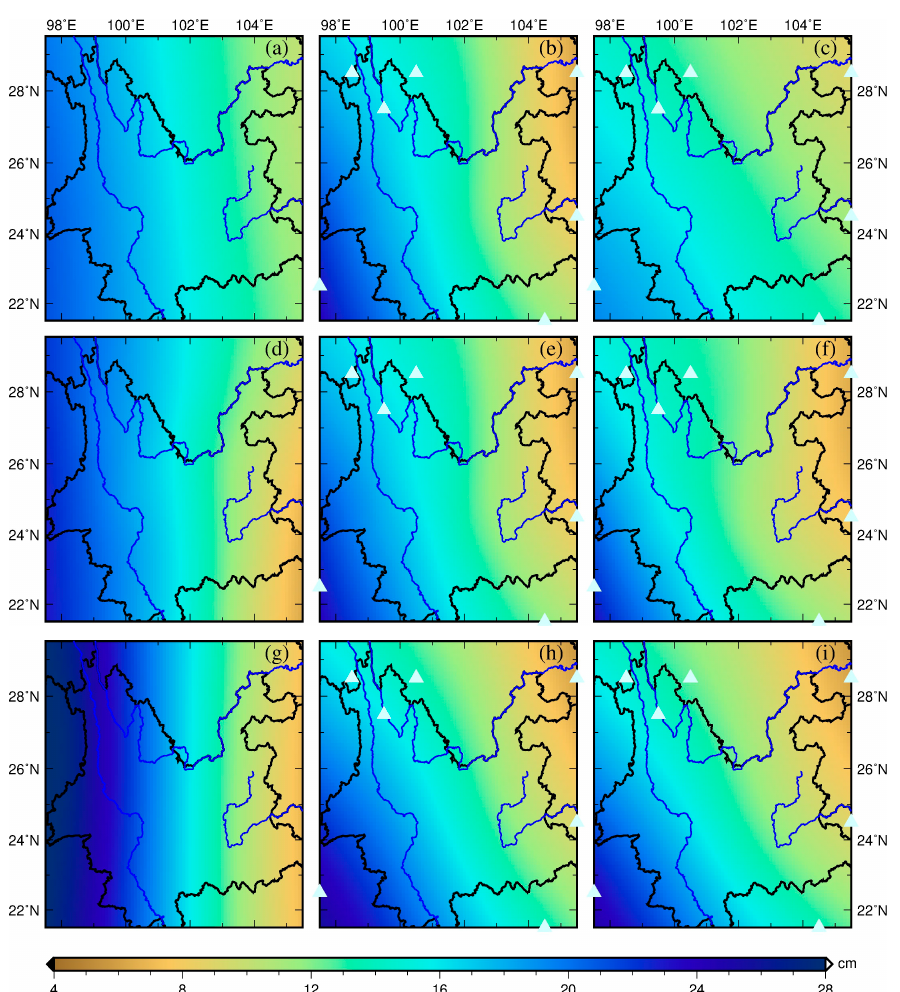
Figure 6. GPS ‐ inferred TWS inverted by TR, ABIC, and HVCE, respectively, ( a,d,g ) without constraints, ( b,e,h ) with spatial GRACE data constraints and ( c,f,i ) with spatial GRACE data constraints and terrain ‐ corrected GPS. Virtual GPS station locations (with white triangles).